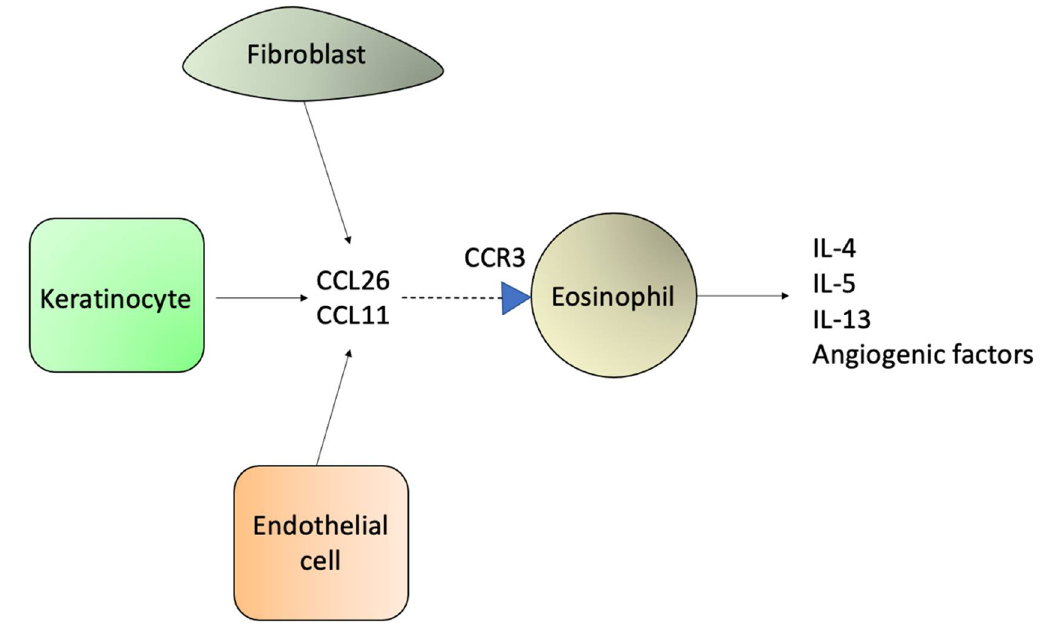
Figure 8. Keratinocytes, fibroblasts, and endothelial cells produce CCL26 and CCL11. These chemokines attract CCR3+ eosinophils.